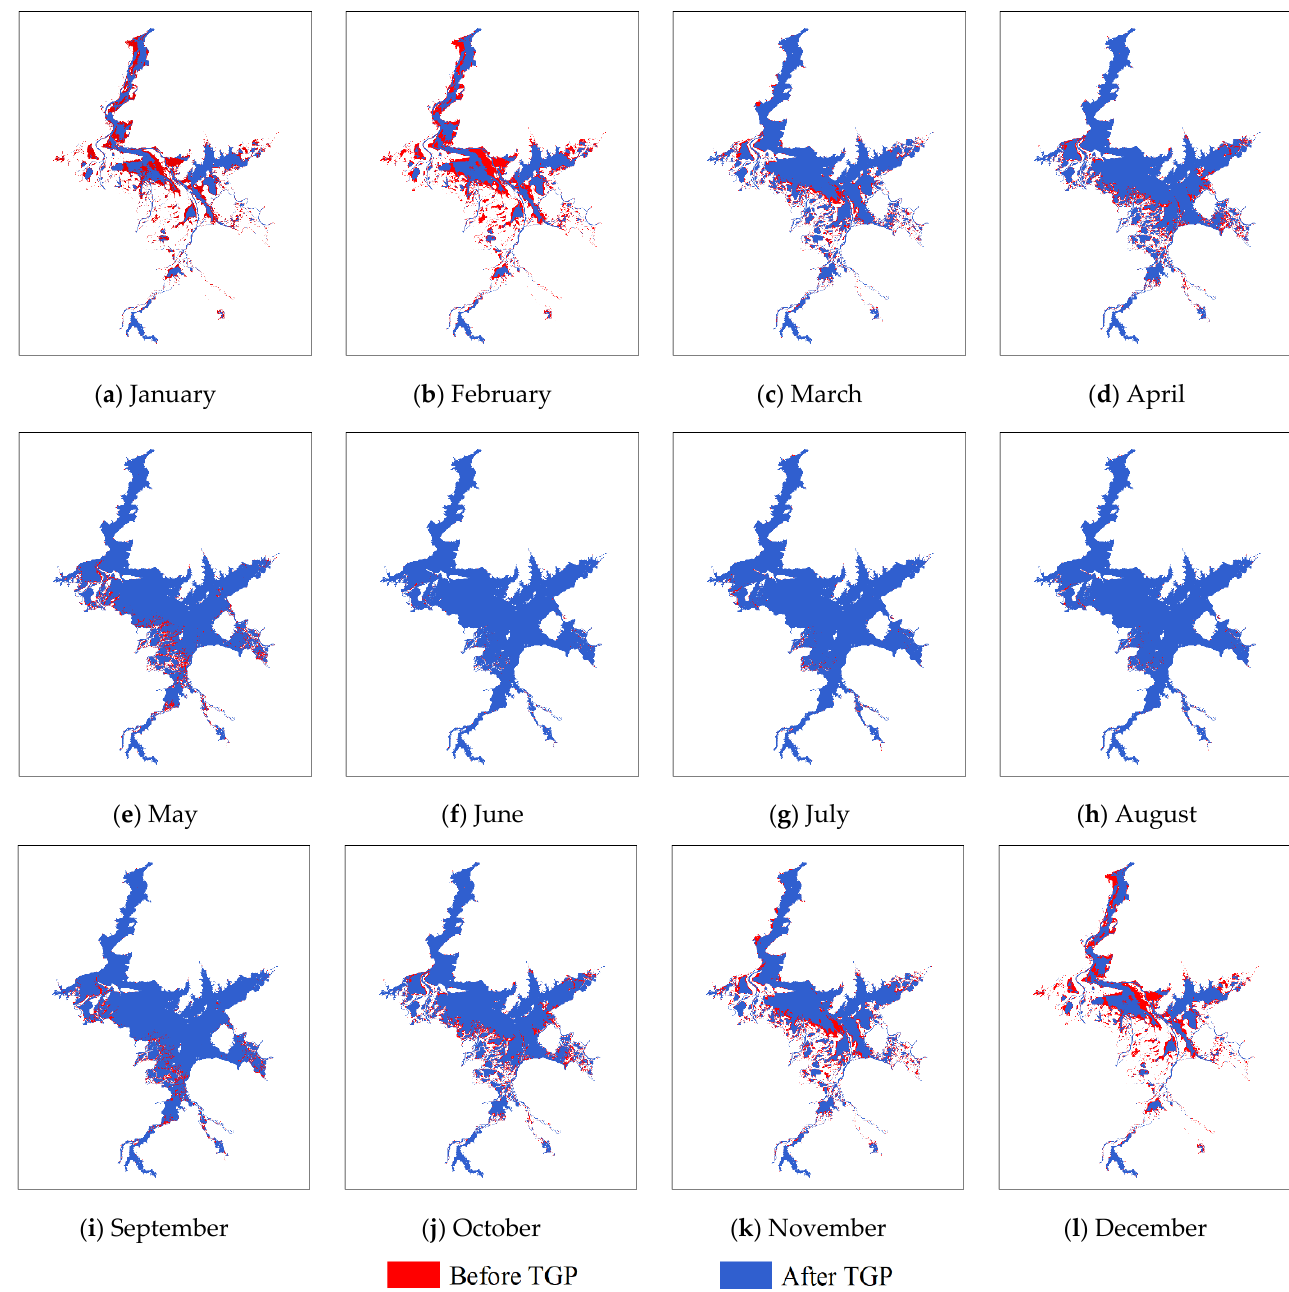
Figure 13. The spatiotemporal variations of Poyang Lake before (red) and after (blue) the TGP.